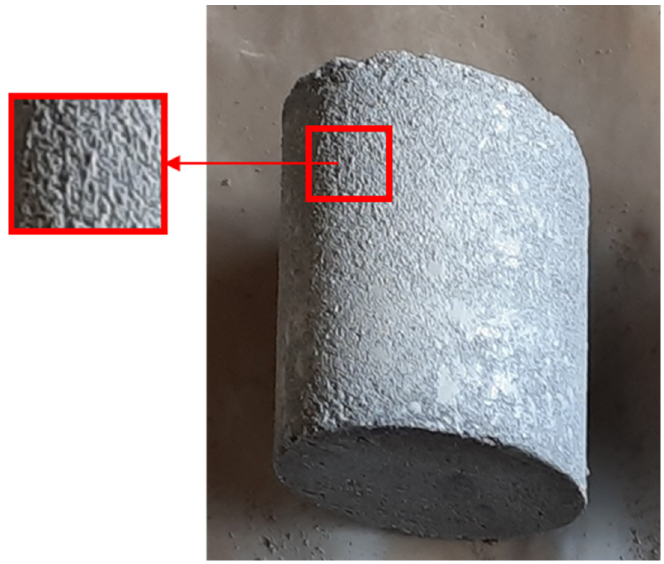
Figure 4. CBGM specimen surface.